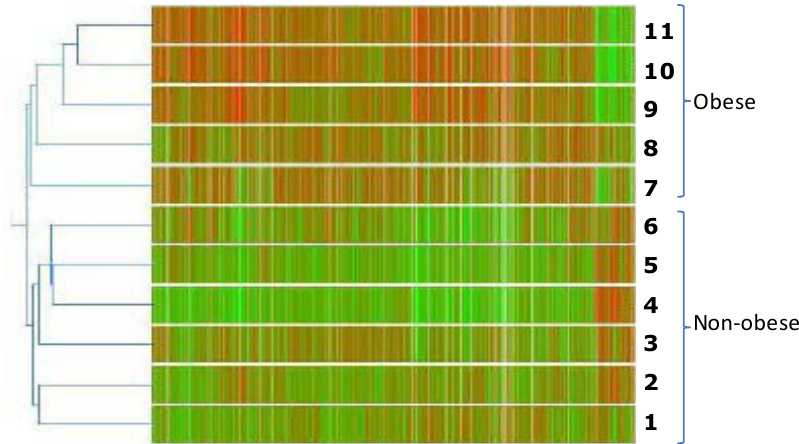
Figure 2. Microarray analysis of the transcripts expressed in the visceral adipose tissue from obese vs. normal-weight (control) prepubertal children. RNA from each patient was subjected to chip analysis using Affymetrix Human Genome U133Plus 2.0 GeneChips. The normal-weight group consists of six individuals (numbers 1–6), and the obese group consists of five patients (numbers 7–11). Bidimensional cluster analysis was performed using a Pearson correlation. The parametric test ANOVA was used to uncover the 1588 genes that were differentially